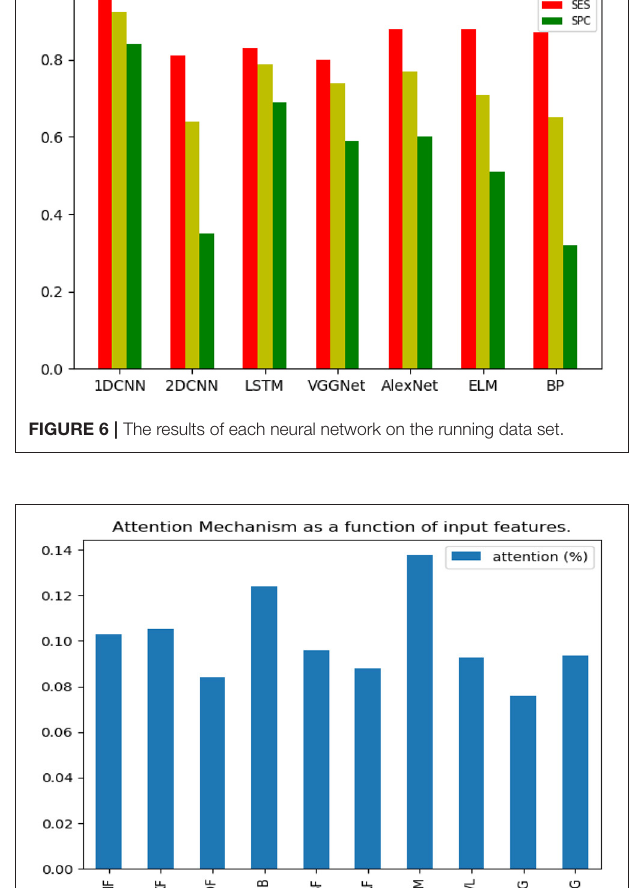
studies have shown that CNN tends to perform better in big data.